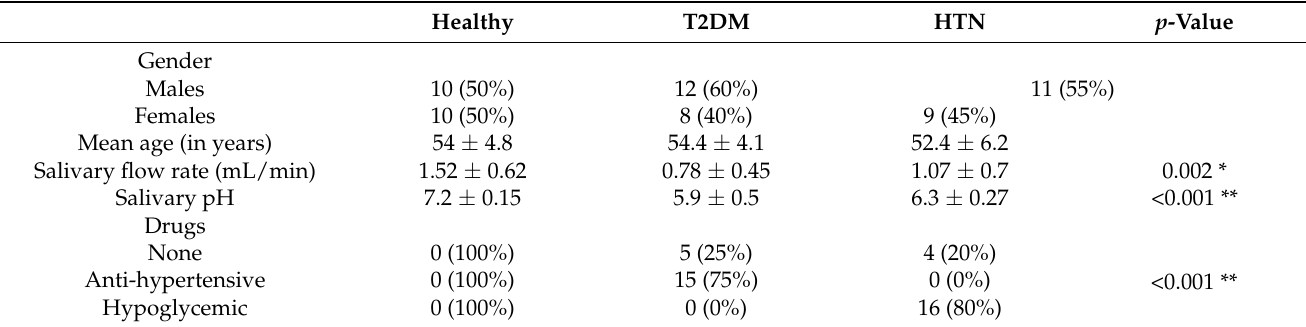
Table 1. Descriptive statistics, mean salivary flow rate, and salivary pH among the groups.